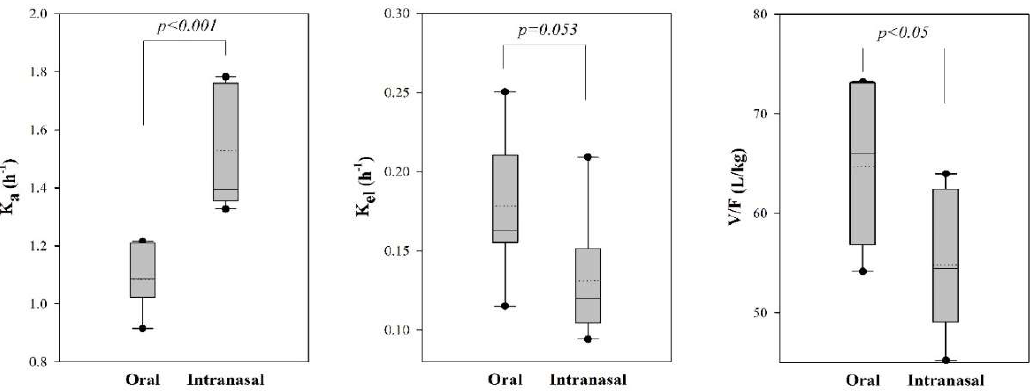
Figure 3. Box plot of model parameters for tadalafil after oral and intranasal administration in dogs ( n = 7/group). The median is displayed as ( − ) and the mean as ( ··· ). Boxes are drawn from 25th to 75th percentiles, and whiskers extend from 5th to 95th percentiles. Circles lie outside the range of the 5th to 95th percentiles.